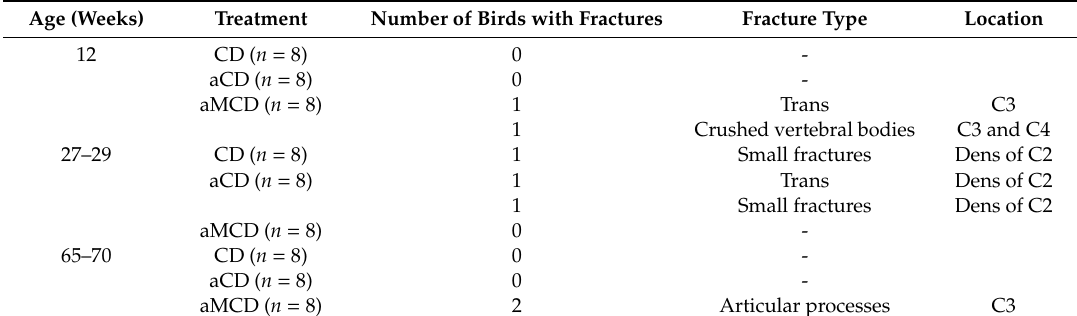
Table 9. Results of radiographic scoring on number of birds with fractures and the types and locations of fractures in conscious and anesthetized chickens.